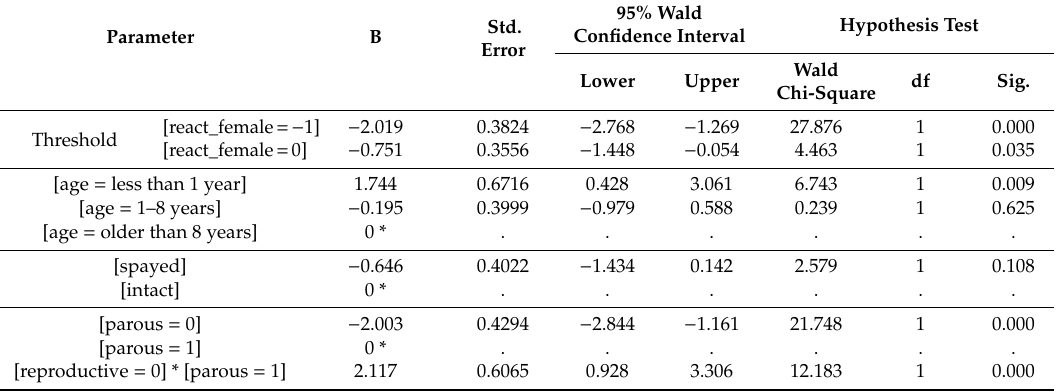
Table 6. Parameter estimates of the mother dogs’ reaction (agonistic, neutral, friendly) to other females in the household as a function of the other females’ age, reproductive status, and parousness. Significant interaction (*) between reproductive status and parousness is included. GzLM with ordinal logistic. * this parameter is set to 0 because it is redundant. Std. Parameter B Error